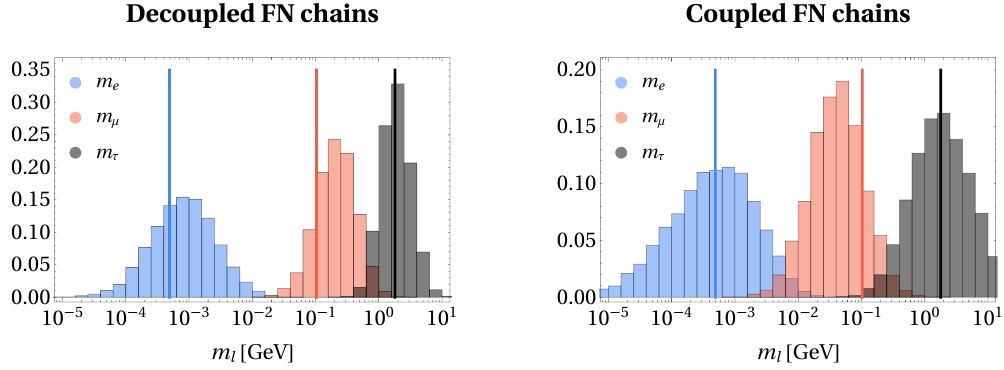
Figure 10 . The distributions of the charged lepton masses for the case of decoupled FN chains, G FN = U(1) 3 (left), with charge assignments in eq. (4.6), and for the coupled FN chains, G FN = FN U(1) FN (right), with charge assignments in eq.